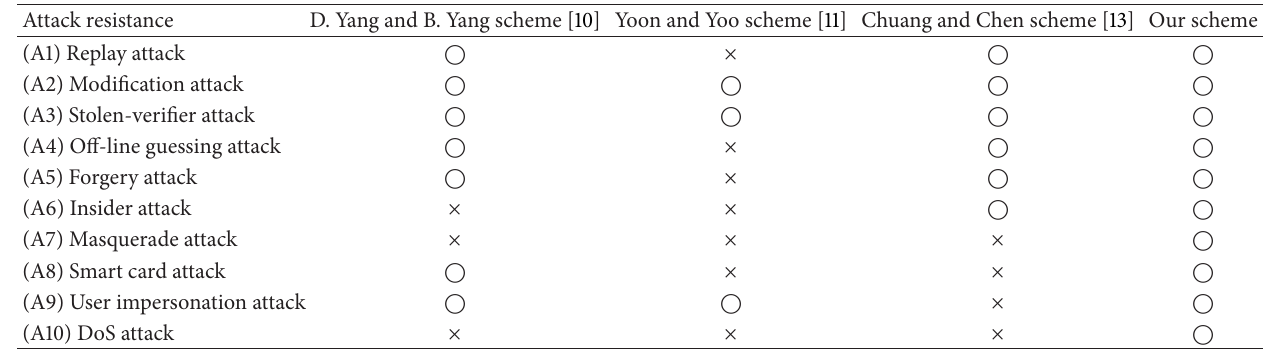
Table 3: Comparison of efficiency measures.